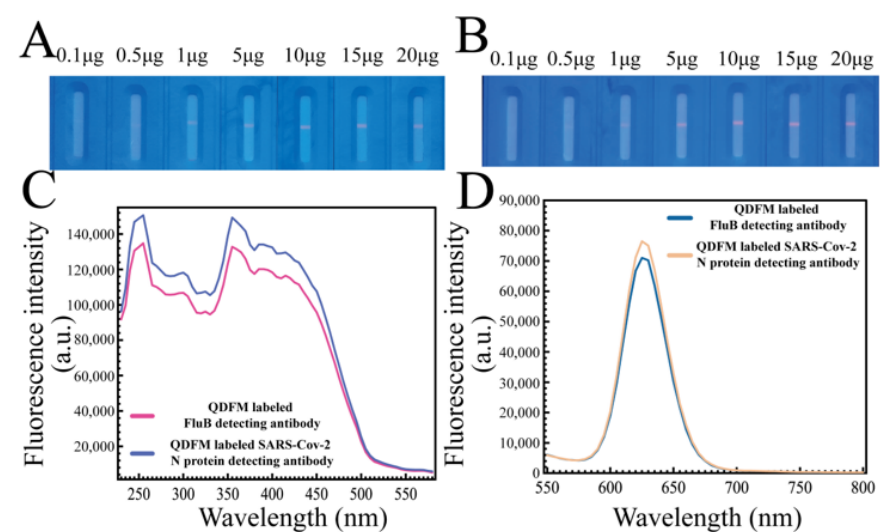
Figure 2. Antibody usage optimization and the characterization of QDFM-mAb conjugation. ( A , B ) The fluorescence images of IgG-captured QDFM-mAb conjugation (A. FluB, B. SARS-Cov-2). ( C ) and ( D ) The excitation and emission spectrum of two kinds of QDFM-mAb conjugation.